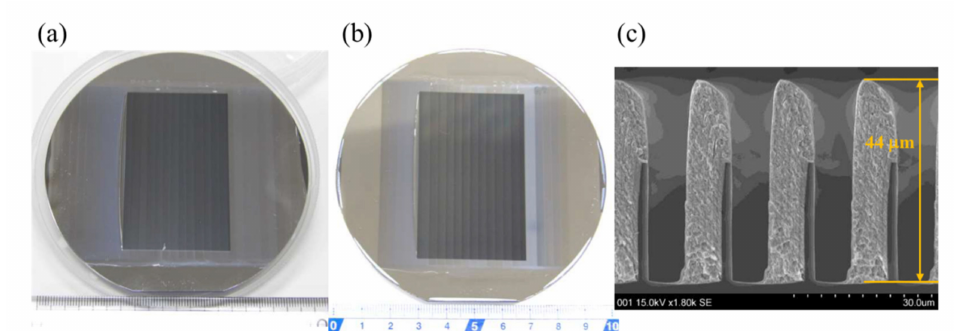
Figure 3. Gd neutron absorption gratings fabricated by the improved oblique evaporation method. Photographs of ( a ) G0 grating, ( b ) G2 grating, and ( c ) SEM image of the cross-section of a grating fabricated with the same condition as ( b